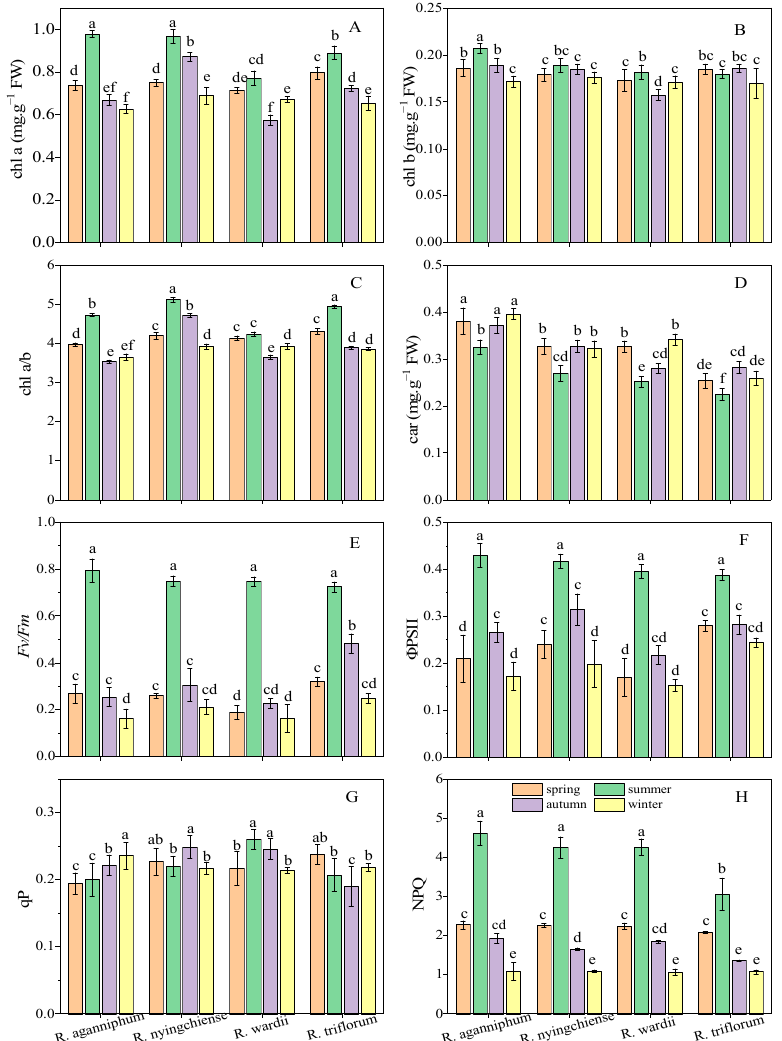
Figure 4. Pigment content ( A – D ) and photosynthetic efficiency ( E – H ) of four Rhododendrons in differ- ent seasons in subalpine habitat on Sygera mountain of the QTP. Values are expressed as mean ± SE ( n = 9), and lowercase letters represent the significant differences among the four Rhododendrons in four seasons ( p <